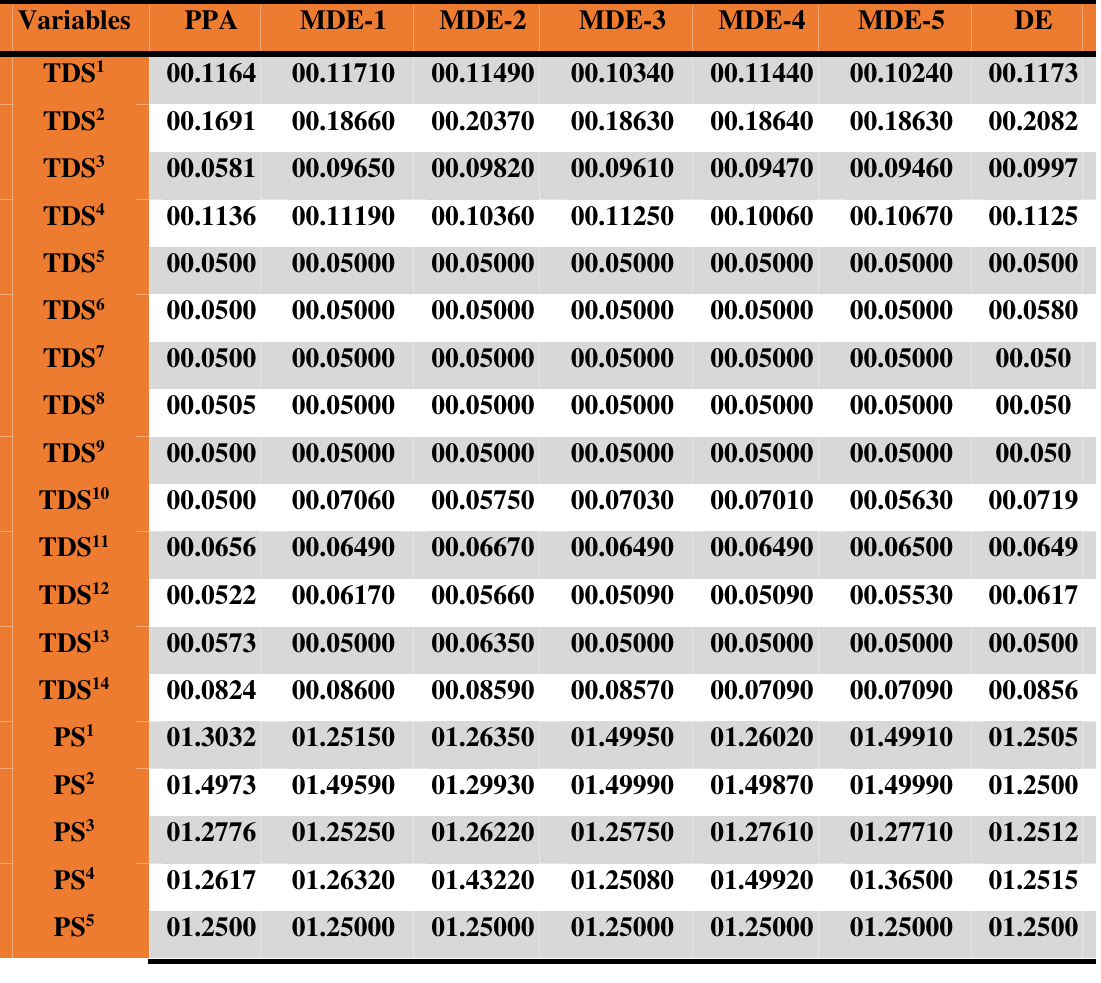
FIG. 4: BEST OBJECTIVE VALUES OBTAINED BY PPA ARE COMPARED WITH DE AND ITS VARIANTS IN SOLVING THE 3-BUS PROBLEM OF DOCRS. TABLE 3: BEST DECISION VARIABLES, OBJECTIVES VALUES, AND NUMBER OF FUNCTION EVALUATION OF PROBLEM 3 6-BUS PROBLEM BY